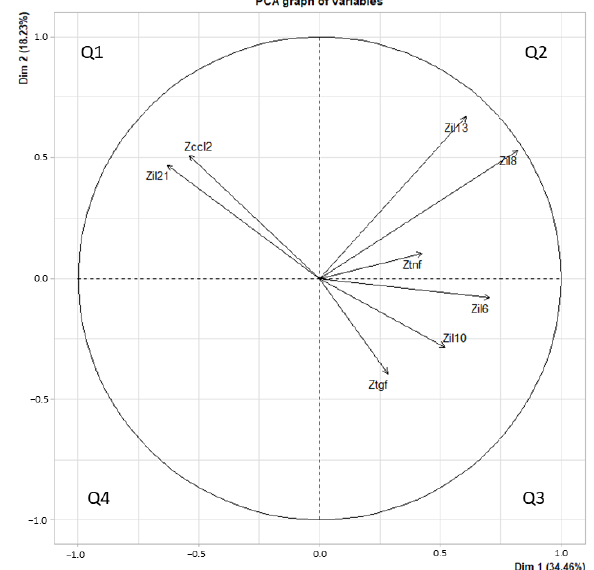
Figure 2. PCA graph of variables for each quadrant. Quadrant 1 (Q1) was represented by CCL-2 and IL-21; quadrant 2 (Q2) by IL-13, IL-8 and TNF- α; quadrant 3 (Q3) by IL10, IL-6 and TGF- β. The x -axis plotted principal component 1 (Dim 1), and the y -axis plotted principal component 2 (Dim 2). Variance explained was represented as a percentage.